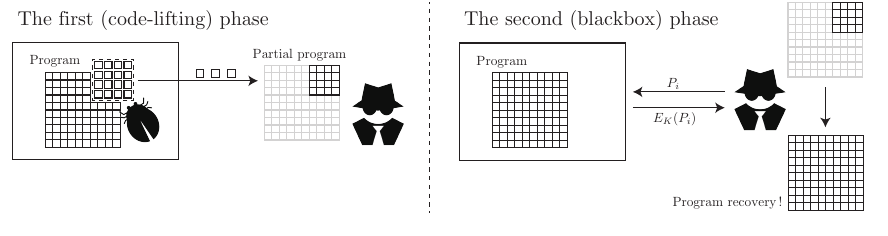
Figure 2: Hybrid code